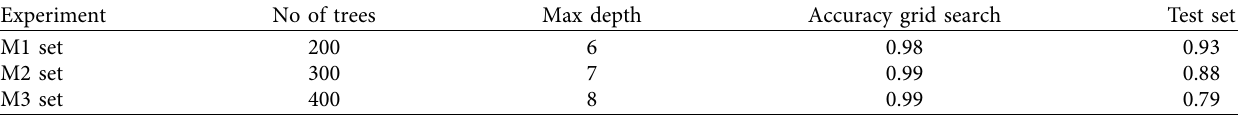
Figure 5: Five-fold cross validation method applied in the parameterisation. Table 3: List of hyper-parameters used for model building using XGBoost regressor.